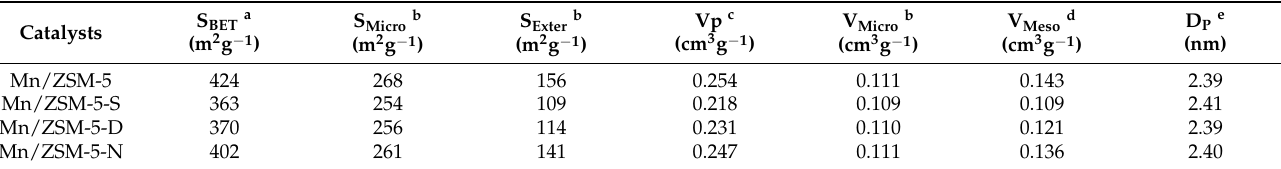
Figure 5. N 2 isotherm adsorption plots and Pore size distribution plots of catalysts: ( a ) Mn/ZSM-5, ( b ) Mn/ZSM-5-S, ( c ) Mn/ZSM-5-D, and ( d ) Mn/ZSM-5-N.